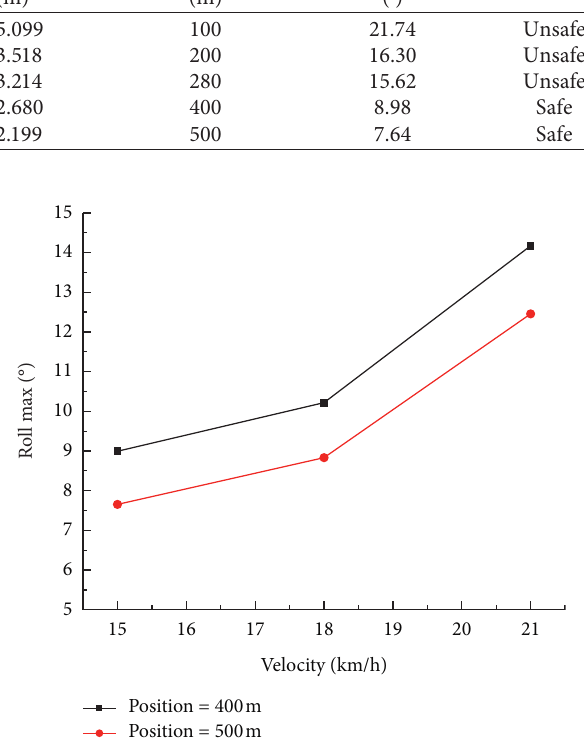
Figure 14: Maximum roll angle at different